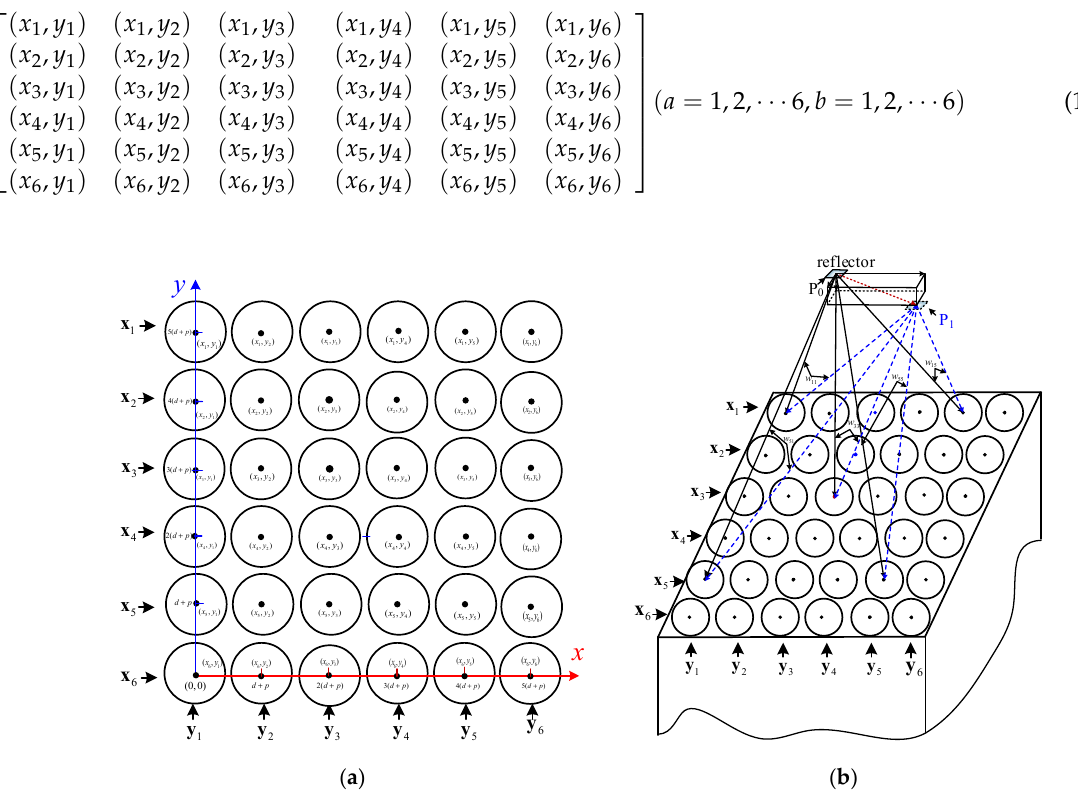
Figure 3. Fiber position matrix and its relation to light intensity matrix. ( a ) Coordinates of the sub- fibers. ( b ) Influence of tool motion on fiber array receiving intensity.